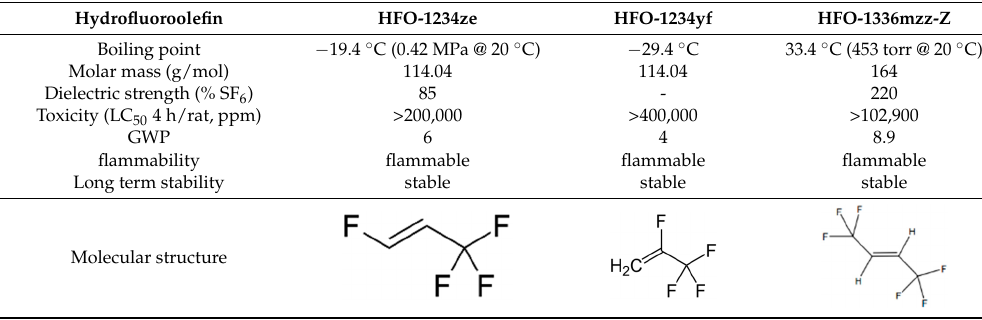
Table 11. Important properties of hydrofluoroolefins candidates [45,46].